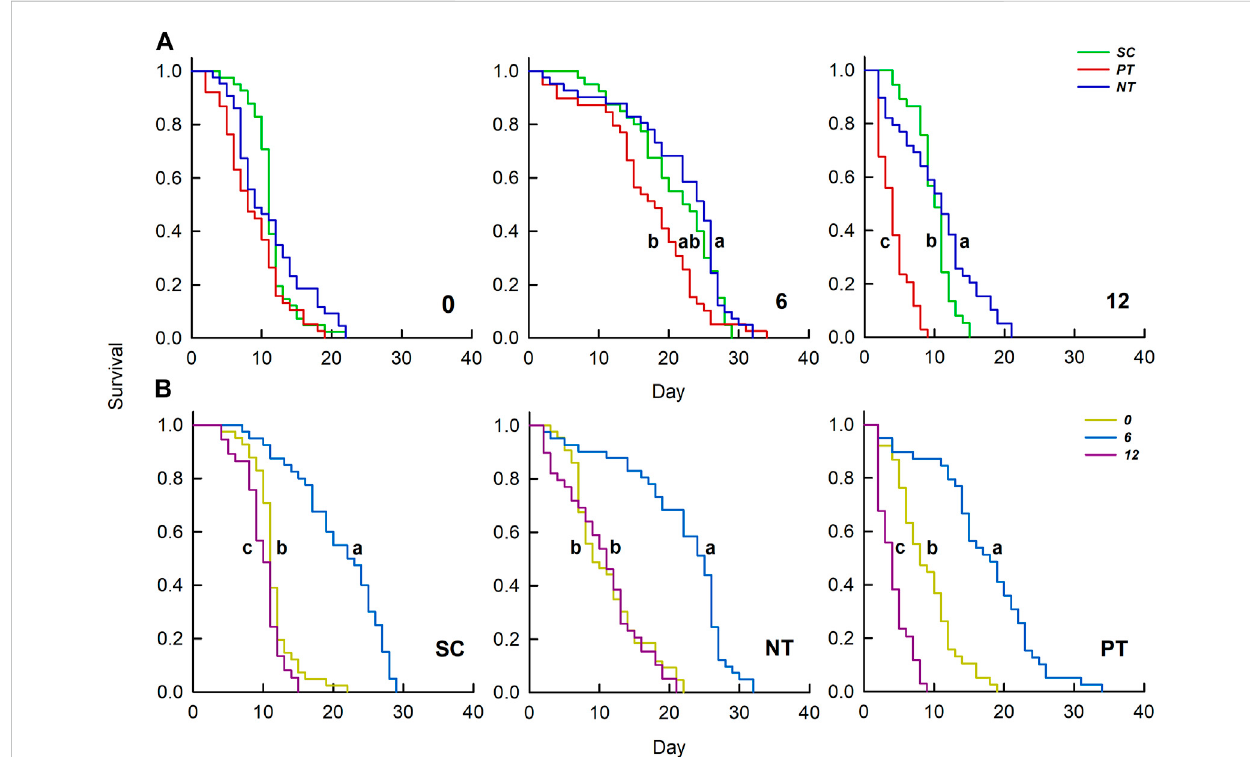
FIGURE 2 Effects of insecticides (A) and temperature amplitudes (B) on the survival curve. Different letters above the curve indicate signi fi cant differences between treatments ( p = 0.05); 0, 6, and 12 represent the different temperature amplitudes; SC, NT, and PT represent the control, high chlorine, and imidacloprid treatment, respectively.